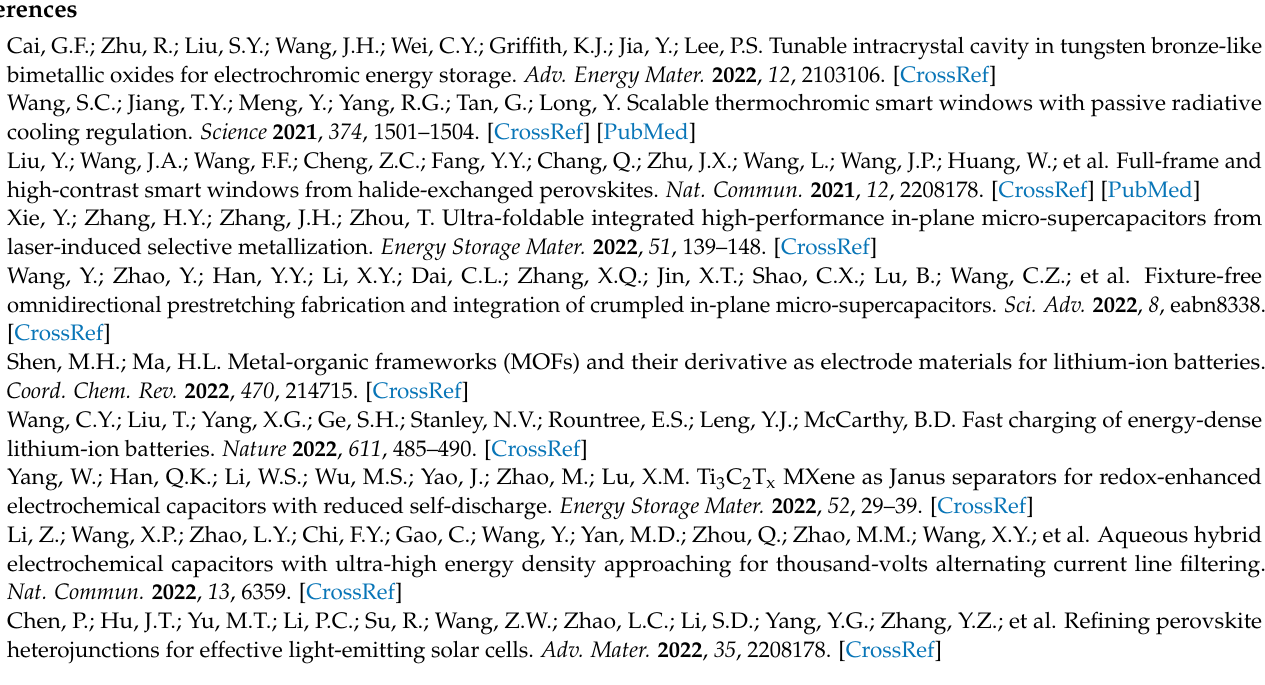
280 nm. Figure S2. The SEM image of TiO 2 NW. Figure S3. SEM-EDS mapping of NW–P 2 W 17 La for P, W, Ti and La. respectively. Figure S4. The 2D (a) and 3D (b) AFM images of FTO–P 2 W 17 La. Figure S5. TEM-EDS elemental mapping patterns of P. Figure S6. Cycle stability of FTO–P 2 W 17 La film at 591 nm under square wave potentials of − 1V and +1V. Figure S7. The AFM of NW–P 2 W 17 La film after cycle stability test. Figure S8. The SEM of NW–P 2 W 17 La film after cycle stability test. Figure S9. CV curve of TiO 2 NW film at a scan rate of 20 mV/s with LiClO 4 /PC as the electrolyte. Figure S10. The transmittance changes of the EESD under different potentials. Figure S11. Polyhedral representa- Figure S13. UV–vis absorption spectra of K 7 [La(H 2 O) x ( α 2 -P 2 W 17 O 61 )]. Table S1 Comparison of electrochromic and energy storage performance in this work and previous works about POMs-based and inorganic metal oxides electrodes. References [16,21,32,33,51–56] are cited in the Supplemen- tary